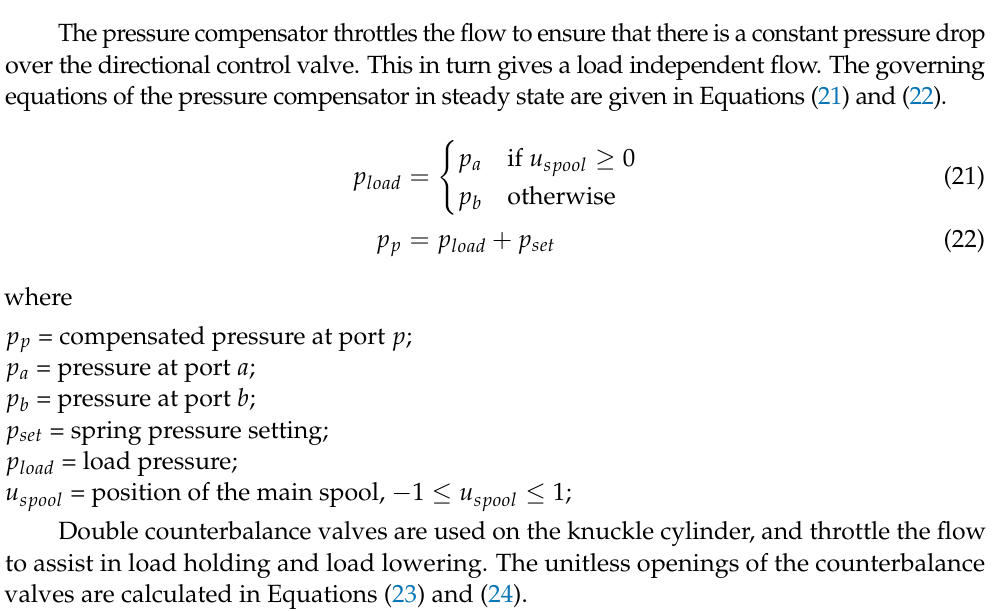
Figure 22. Hydraulic circuit for the valve-controlled